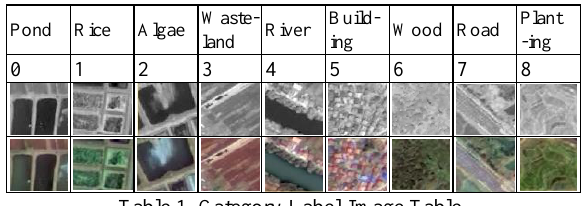
Table 1. Category-Label-Image